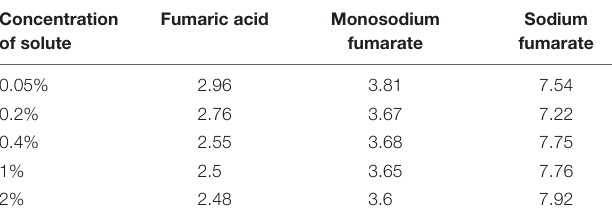
TABLE 2 | The pH of fumaric acid and its sodium salts at different concentrations. Concentration of